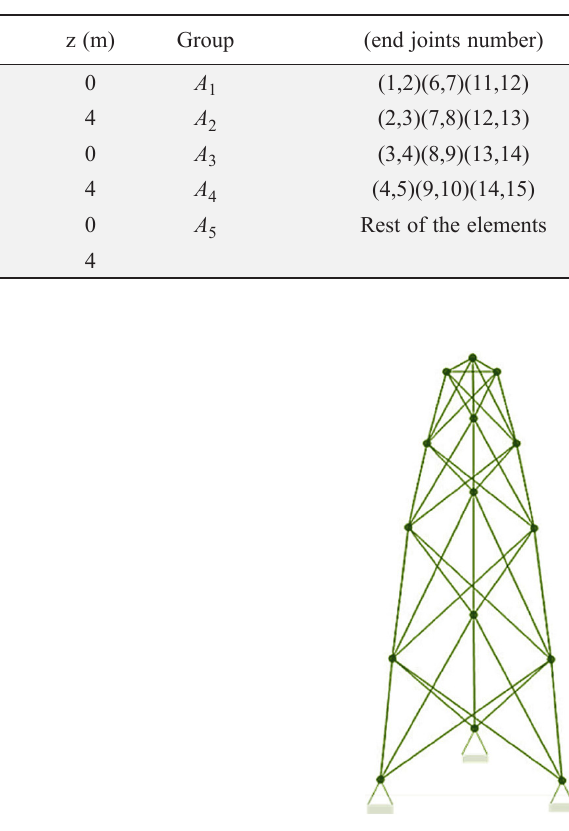
Table 9. Initial layout and member grouping for the spatial 39-bar truss problem